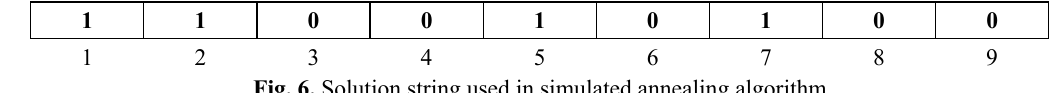
Fig. 6. Solution string used in simulated annealing algorithm